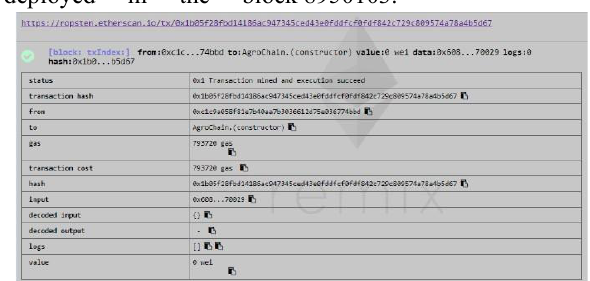
Fig. 4.1 Transaction log after deploying a smart contract